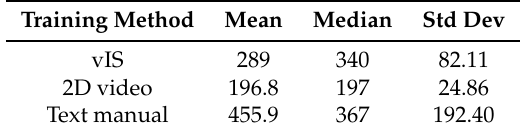
Table 1. Training time of all three training methods (in seconds).